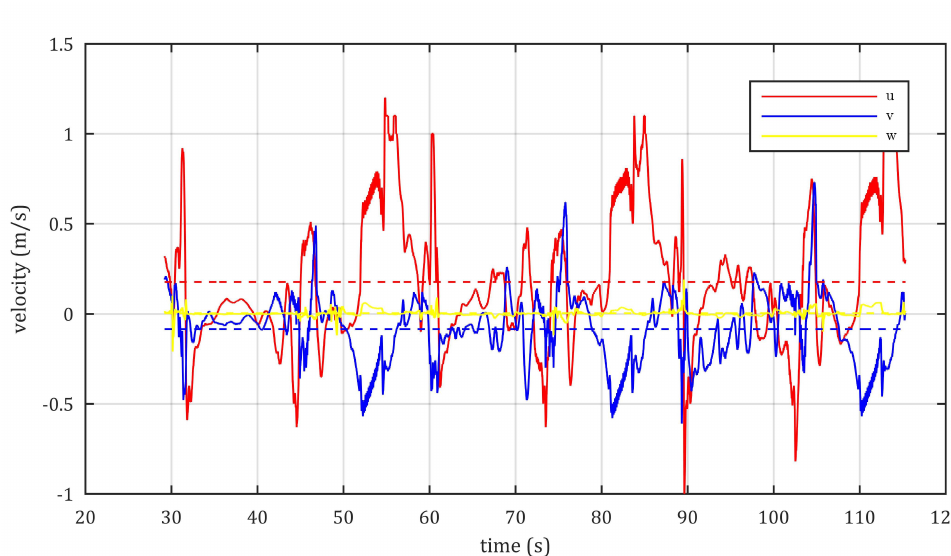
Figure 11. Time series of the three velocity components (longitudinal- u , vertical- v and transversal- w ). Broken lines represent the averages of each